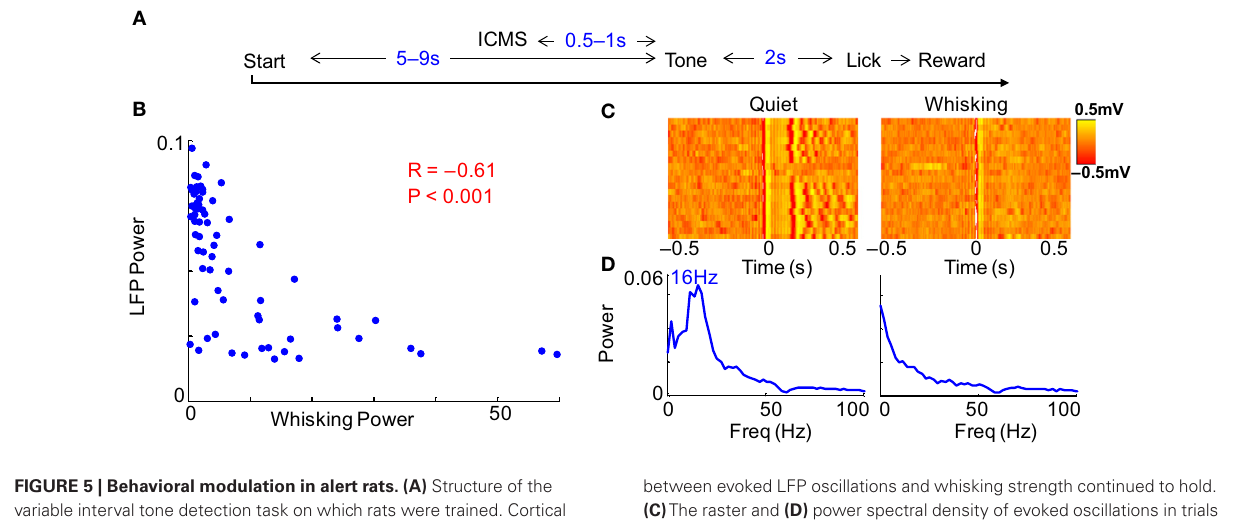
FIGURE 5 | Behavioral modulation in alert rats. (A) Structure of the variable interval tone detection task on which rats were trained. Cortical microstimulation was introduced 0.5–1 s before the tone stimulus on some trials and had no relevance to the task. (B) The inverse relation